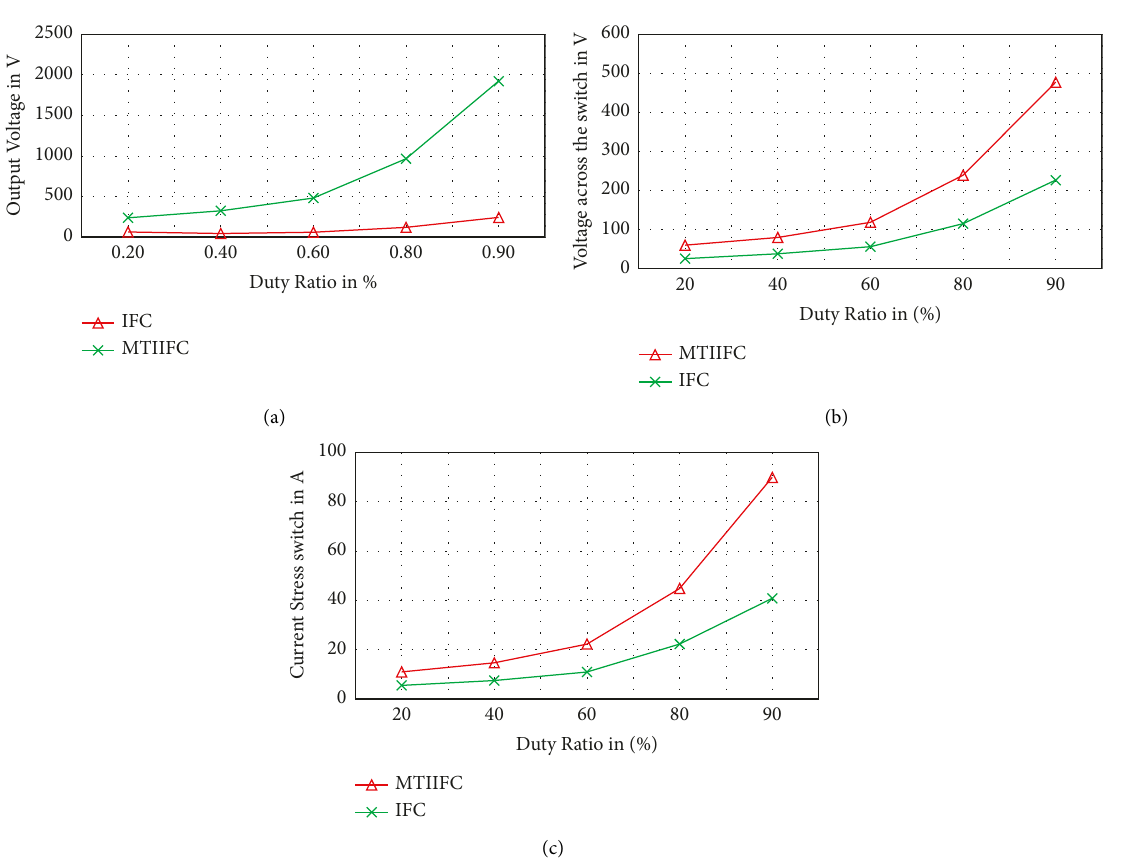
Figure 12: Comparison of the proposed MTIIFC with the conventional IFC. (a) Output voltage vs. duty cycle. (b) Voltage stress vs. duty cycle. (c) Current stress vs. duty